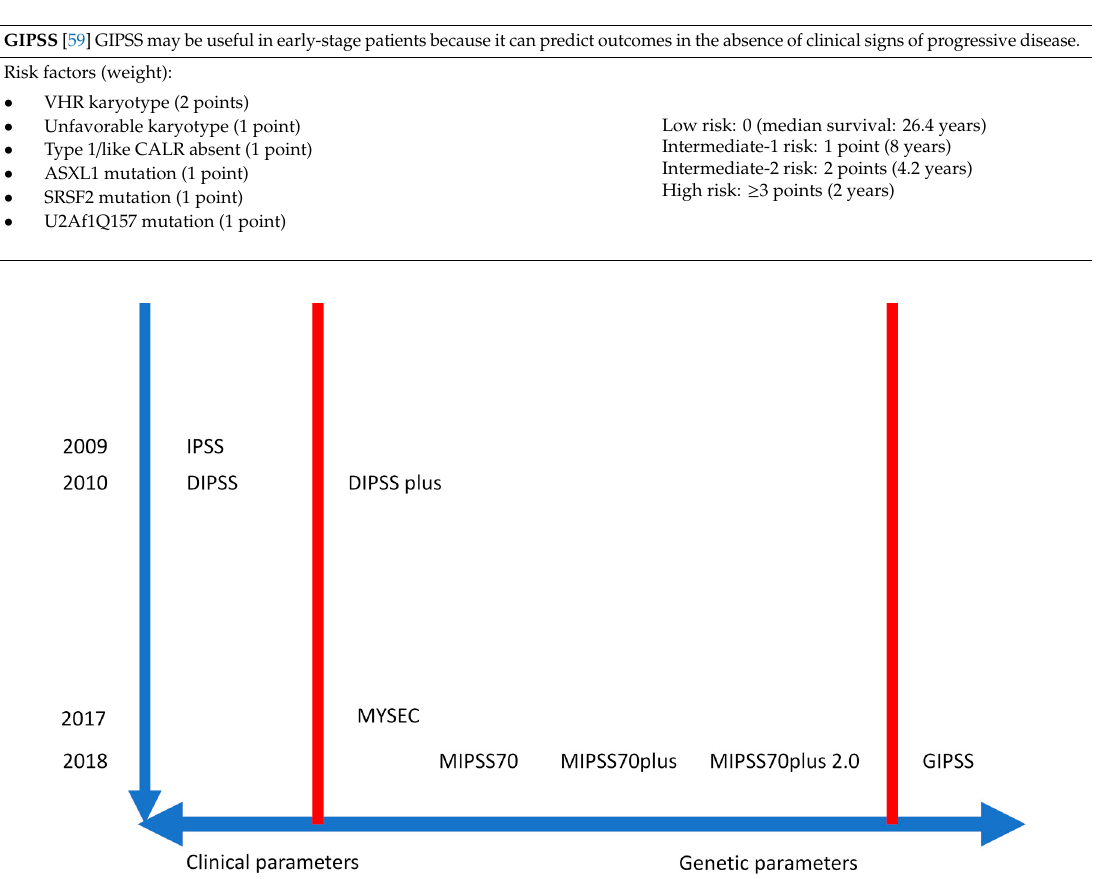
Figure 1. The different scores developed during the last two decades are based only on clinical parameters (IPSS and DIPSS), on clinical and genetic parameters (DIPSS plus, MYSEC, MIPSS70, MIPSS70plus, MIPSS70plus 2.0), or on genetic parameters only (GIPSS).